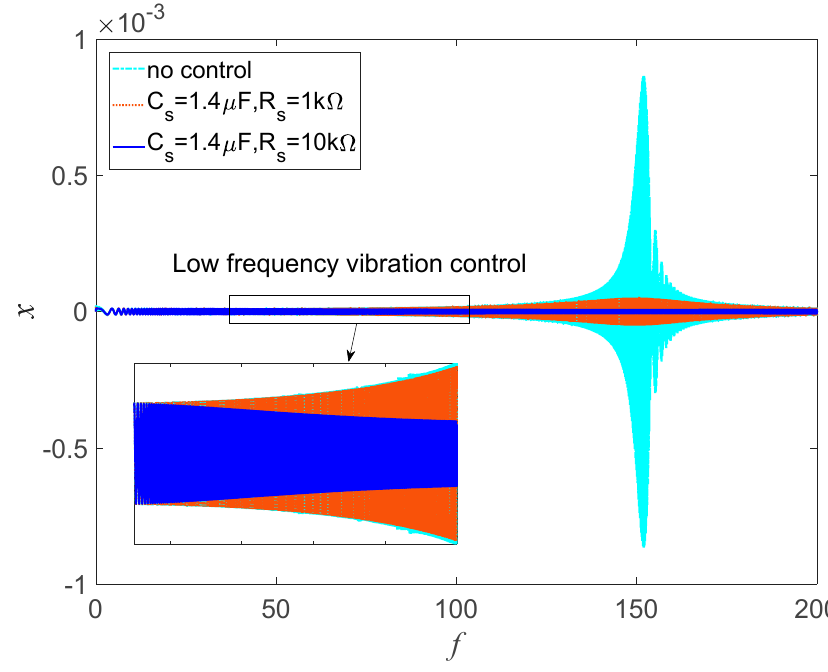
Figure 18. Time history response of the transducer under sweep sine excitation.